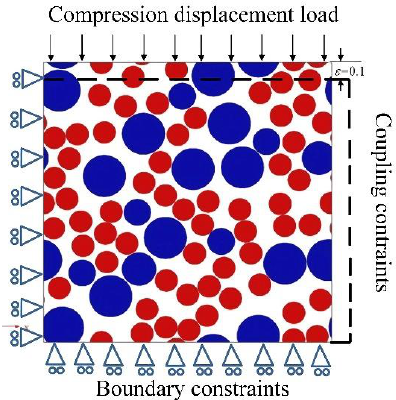
Table 1. Material parameters of the explosive particles and binder. Explosive Particles